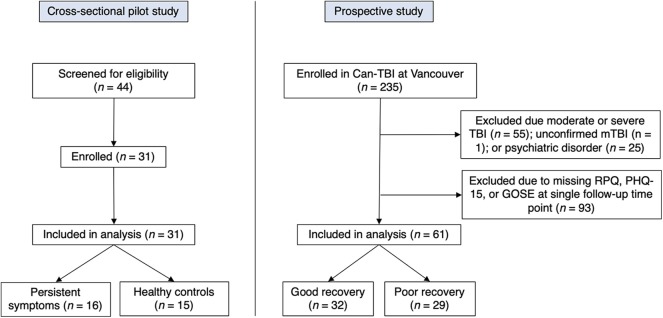
Flow chart outlining participant recruitment for both study samples.